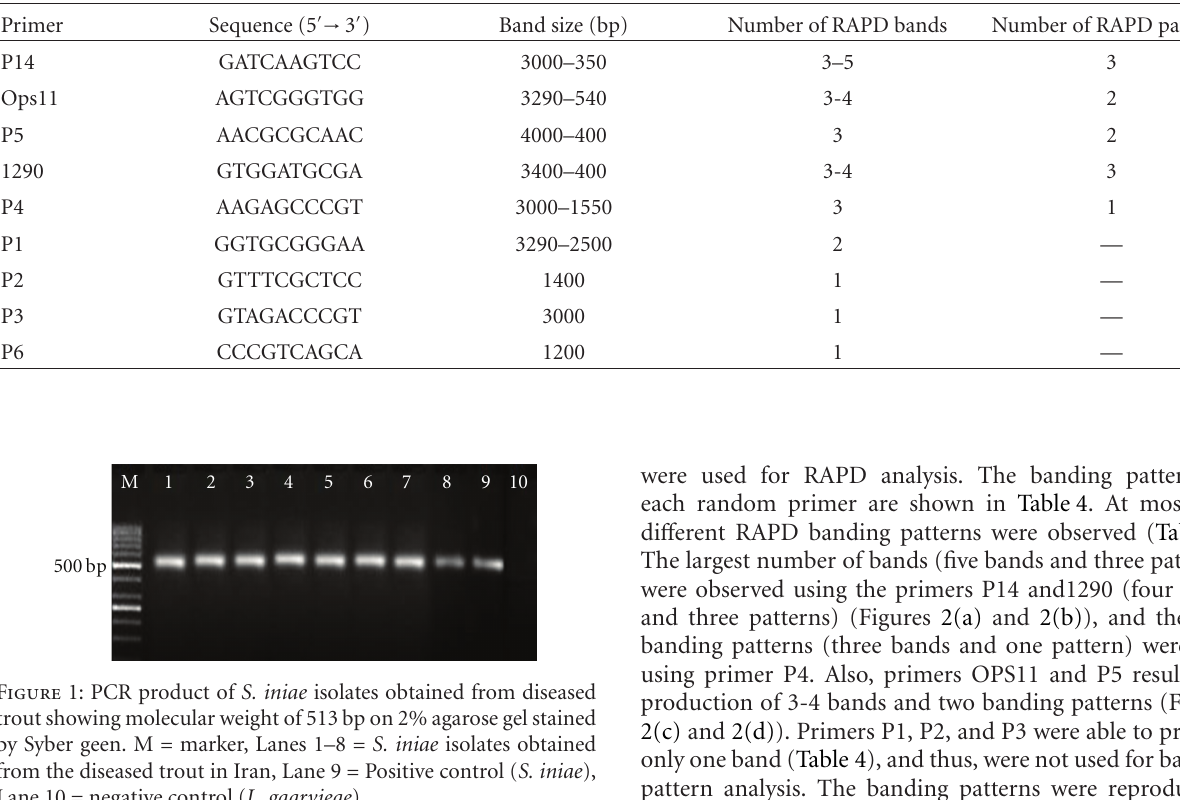
Table 4: Banding patterns observed in S. iniae isolates using RAPD analysis. The numbers of di ff erent DNA banding profiles are listed with each primer used in the typing procedure. The P14 primer was able to discriminate between the isolates with the largest number of di ff erent banding patterns. — = indicating of no RAPD pattern.